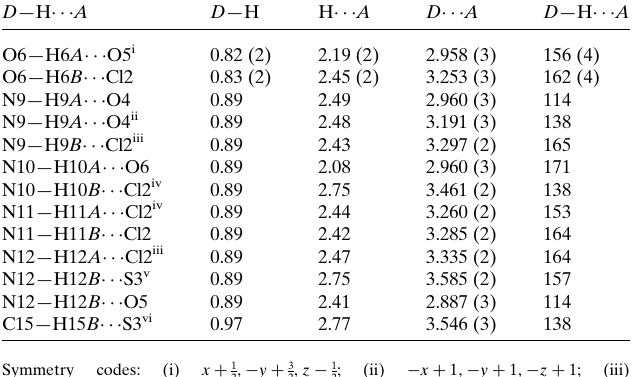
Table 2 Hydrogen-bond geometry (A˚ , (cid:5) ) for (II).